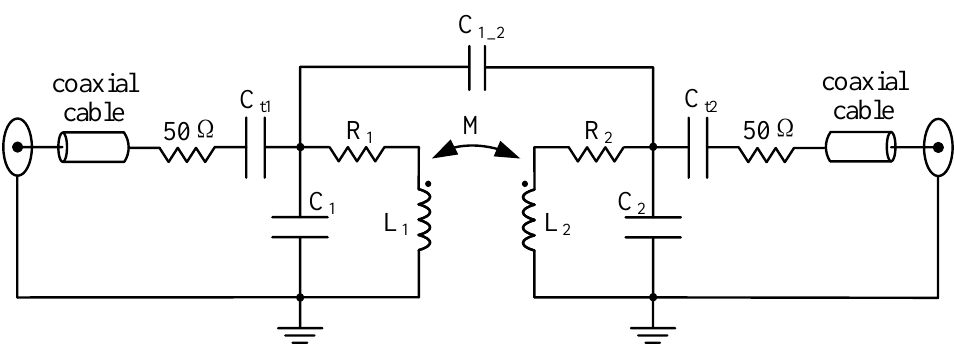
Figure 8. The remote resistance matching for the orthogonal dual-coil probe.